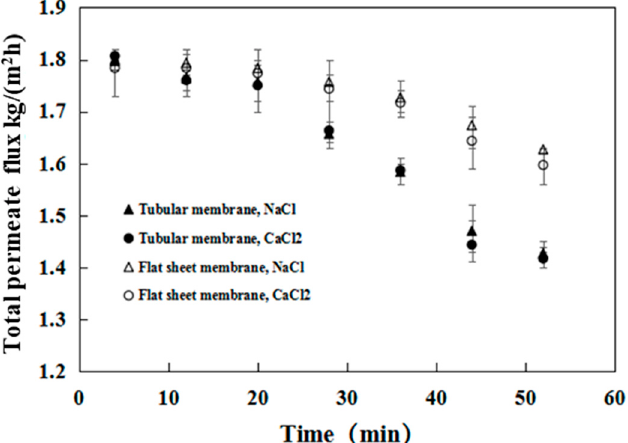
Figure 9. Influence of salt species and operation time on the permeate flux of the tubular and flat- sheet membranes. (Feed: NaCl (15 wt.%)/ethyl acetate (4.8 wt.%)/water and CaCl 2 (15 wt.%)/ethyl acetate (4.8 wt.%)/water; Operation temperature: 40 °C).